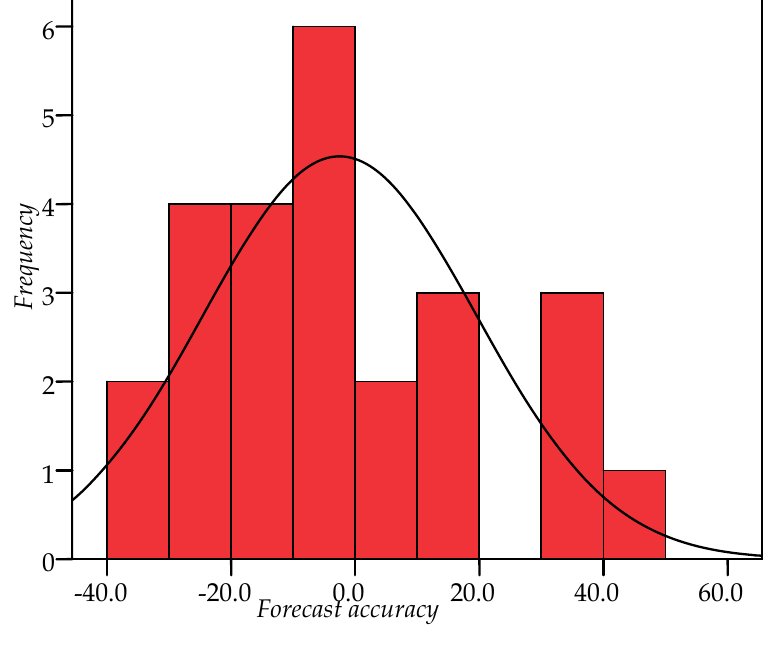
Figure 1. Inaccuracies of the toll road traffic